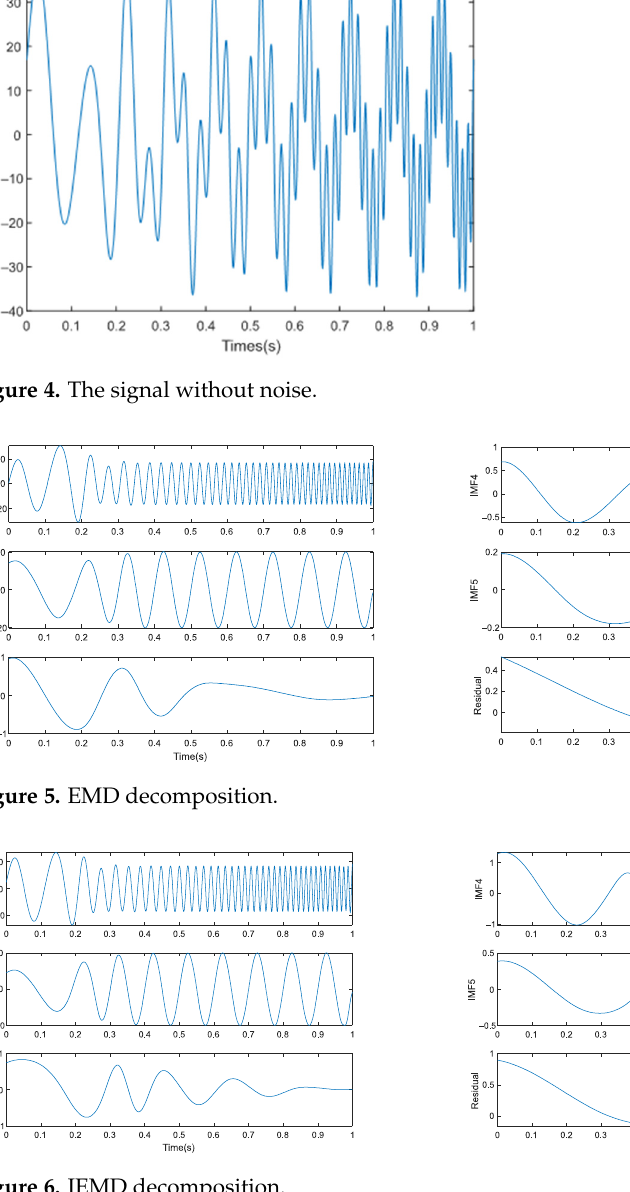
Figure 6. IEMD decomposition.